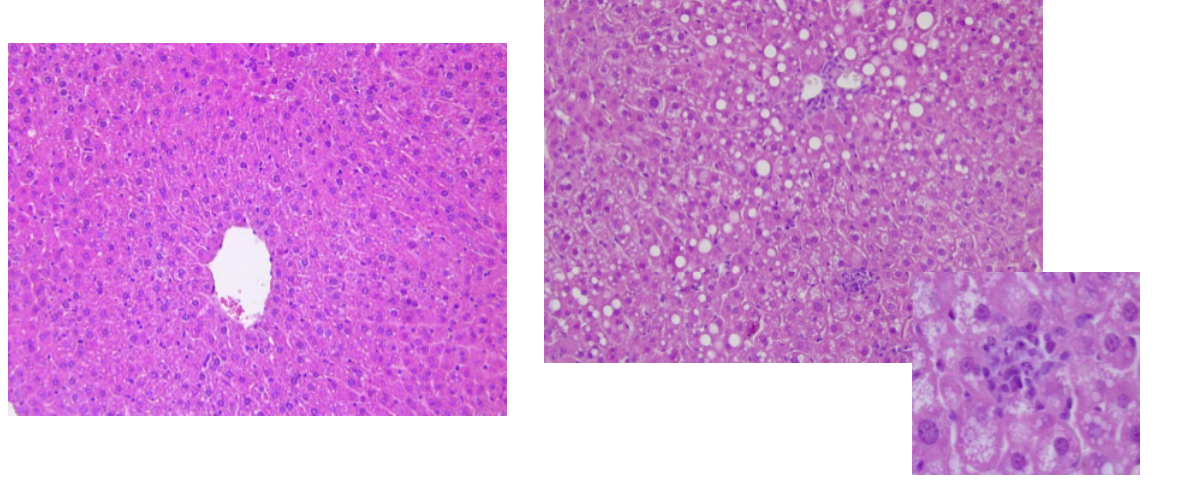
3. Effect of feeding a Western-style diet on the liver. Representative photomicrographs of hematoxylin and eosin staining of liver sections (200×) of mice fed with control or Western-style diet for 6